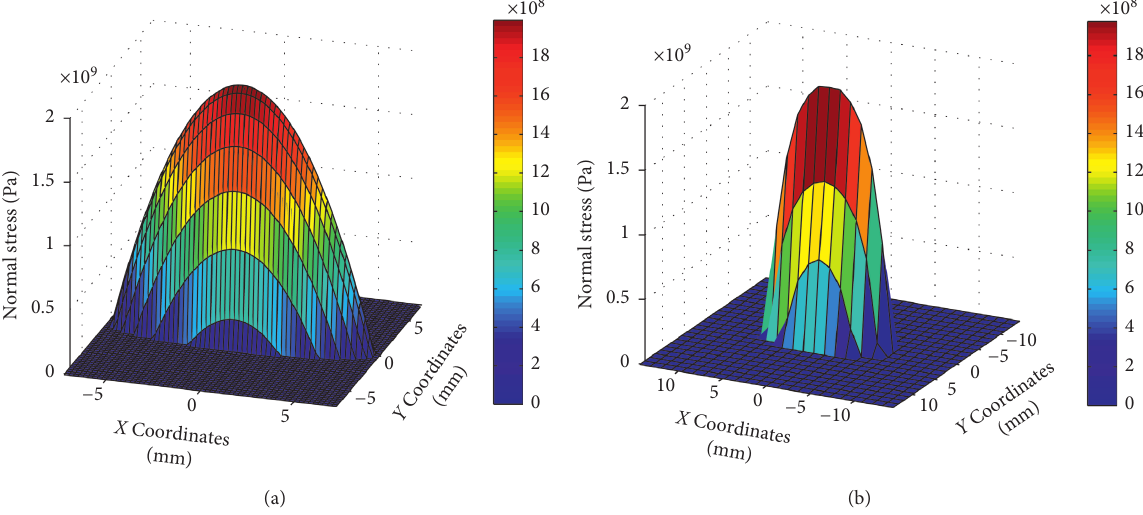
Figure 4: Contact pressure distribution (wheelset transverse displacement is − 9mm) based on: (a) Hertz; (b)